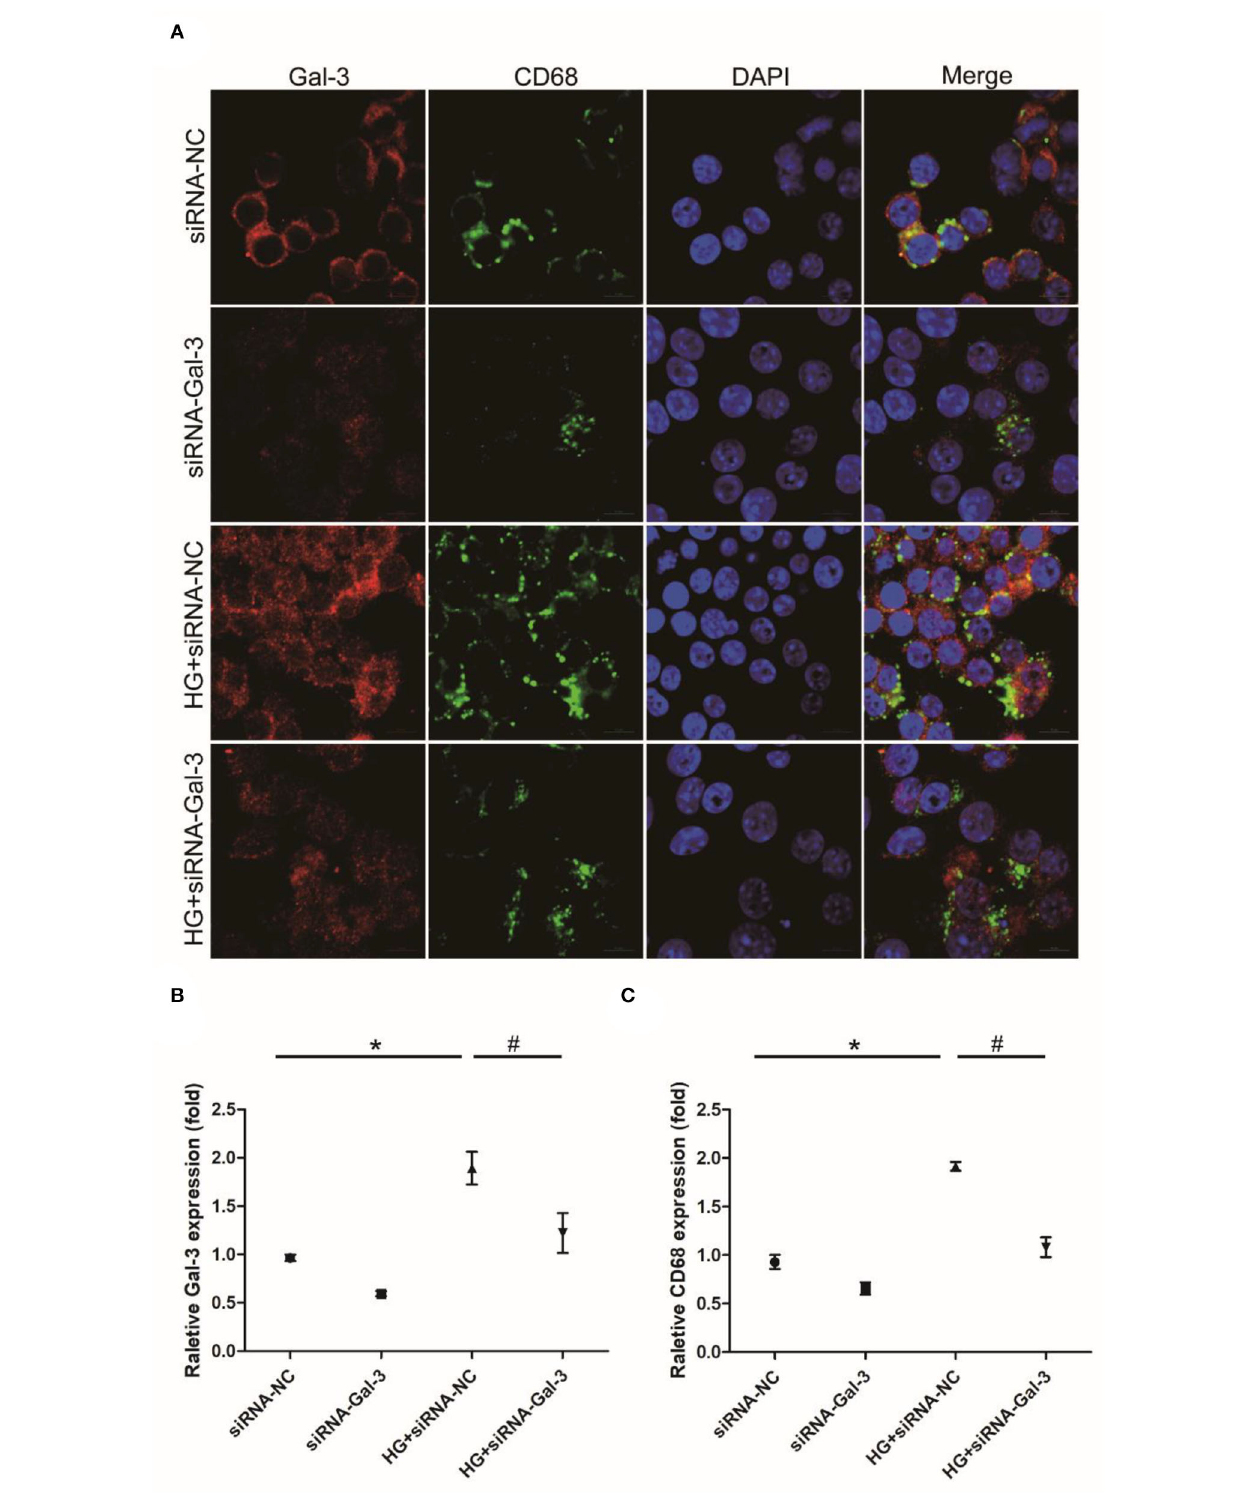
FIGURE 8 | Gal-3 knockdown induced HG-induced macrophage infiltration (A) Immunohistochemical staining of CD68 and Gal-3. Representative analysis of CD68 (B) and Gal-3 (C) . Data are shown as mean ± SD. n = 3, * P < 0.05 vs. siRNA-NC; # P < 0.05 vs. HG + siRNA-NC.